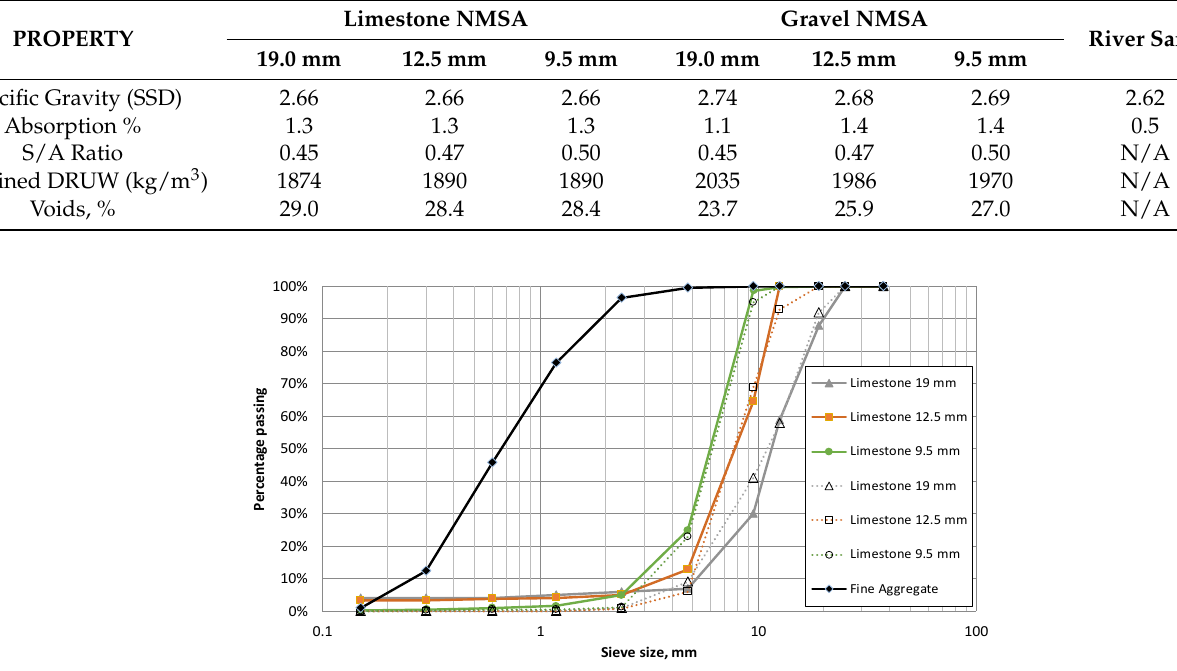
Figure 1. Particle size distribution of cement, SCMs, and filler (25 mm = 1 in.). Table 2. Physical properties of aggregates (25 mm = 1 in.). Table 2. Physical properties of aggregates (25 mm = 1 in.).